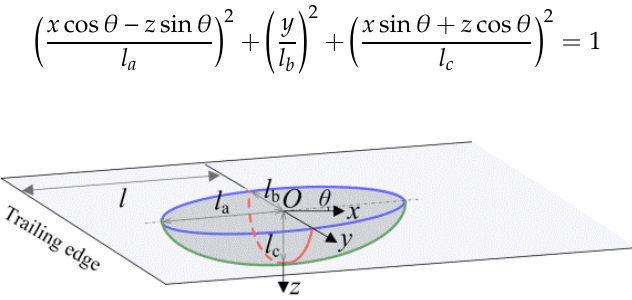
Figure 3. Ellipsoidal approximation of the TP geometry.